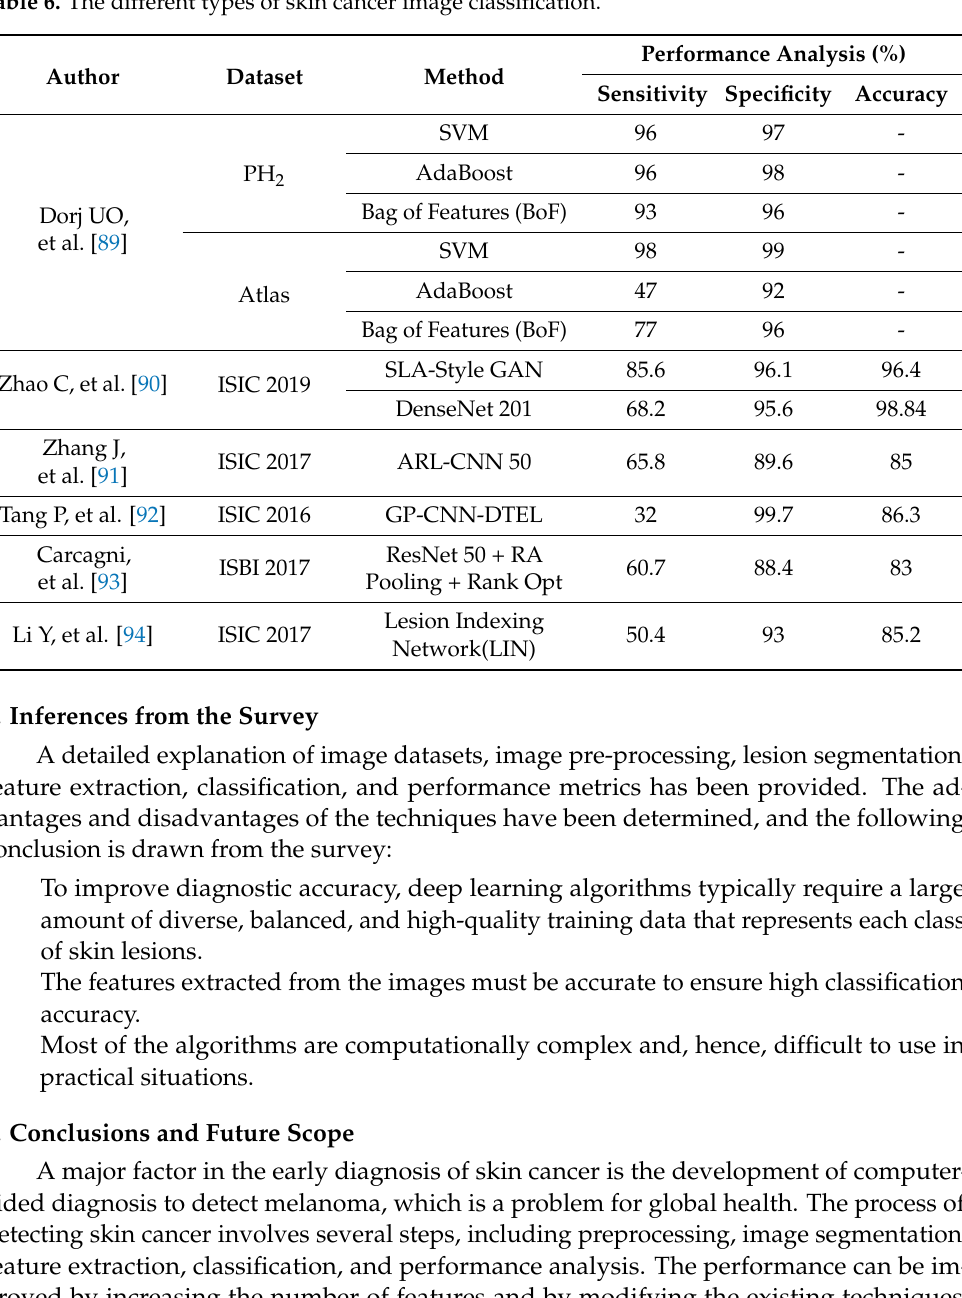
Table 6. The different types of skin cancer image